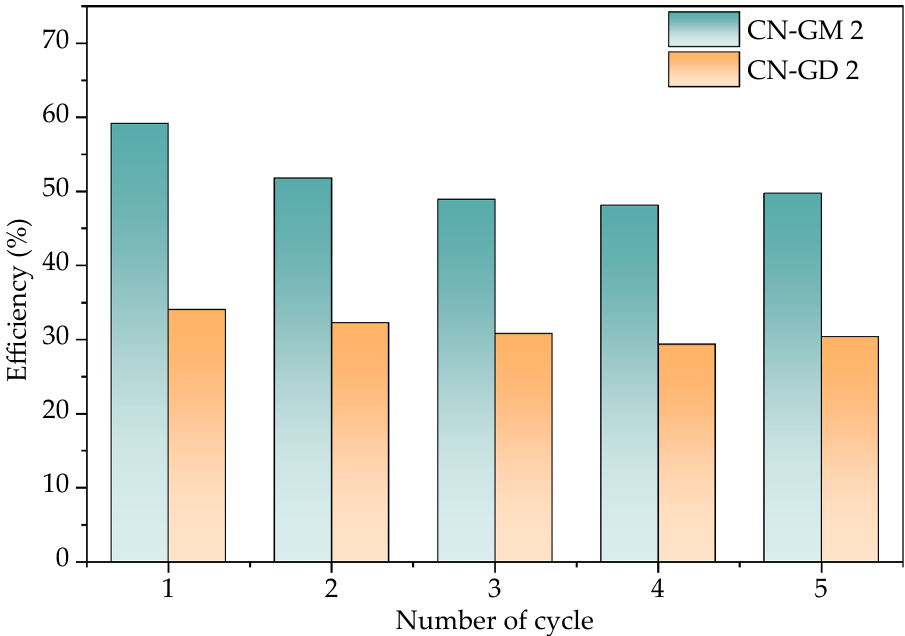
Figure 6. Stability tests of CN-GM 2 and CN-GD 2 materials.